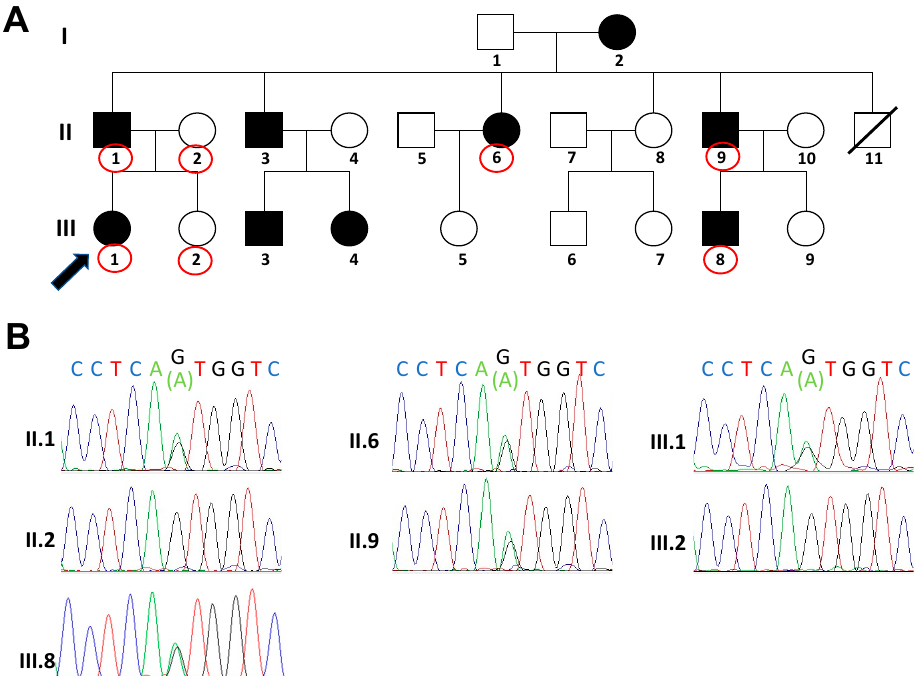
Figure 2. ( A ) Family pedigree of the patient and her relatives. Affected individuals are shown as filled symbols, whereas the patient is identified by the arrow. Family members analysed for KRT5 pathogenic variant are indicated by red circles. ( B ) Sequence electropherograms of KRT5 exon 5 region containing the G > A transition (c.967 G > A) (pVal323Met). The pathogenic variant is present in affected family members only.